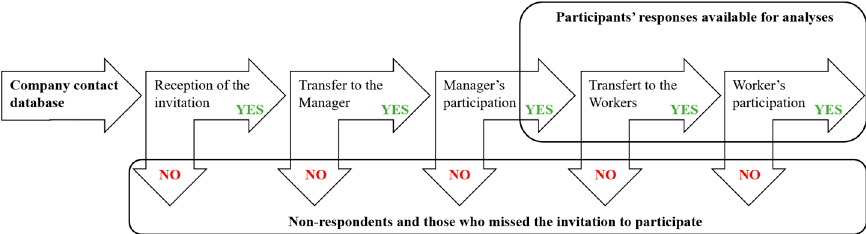
Figure 1. Dissemination strategy used in the framework of the NanoExplore survey.